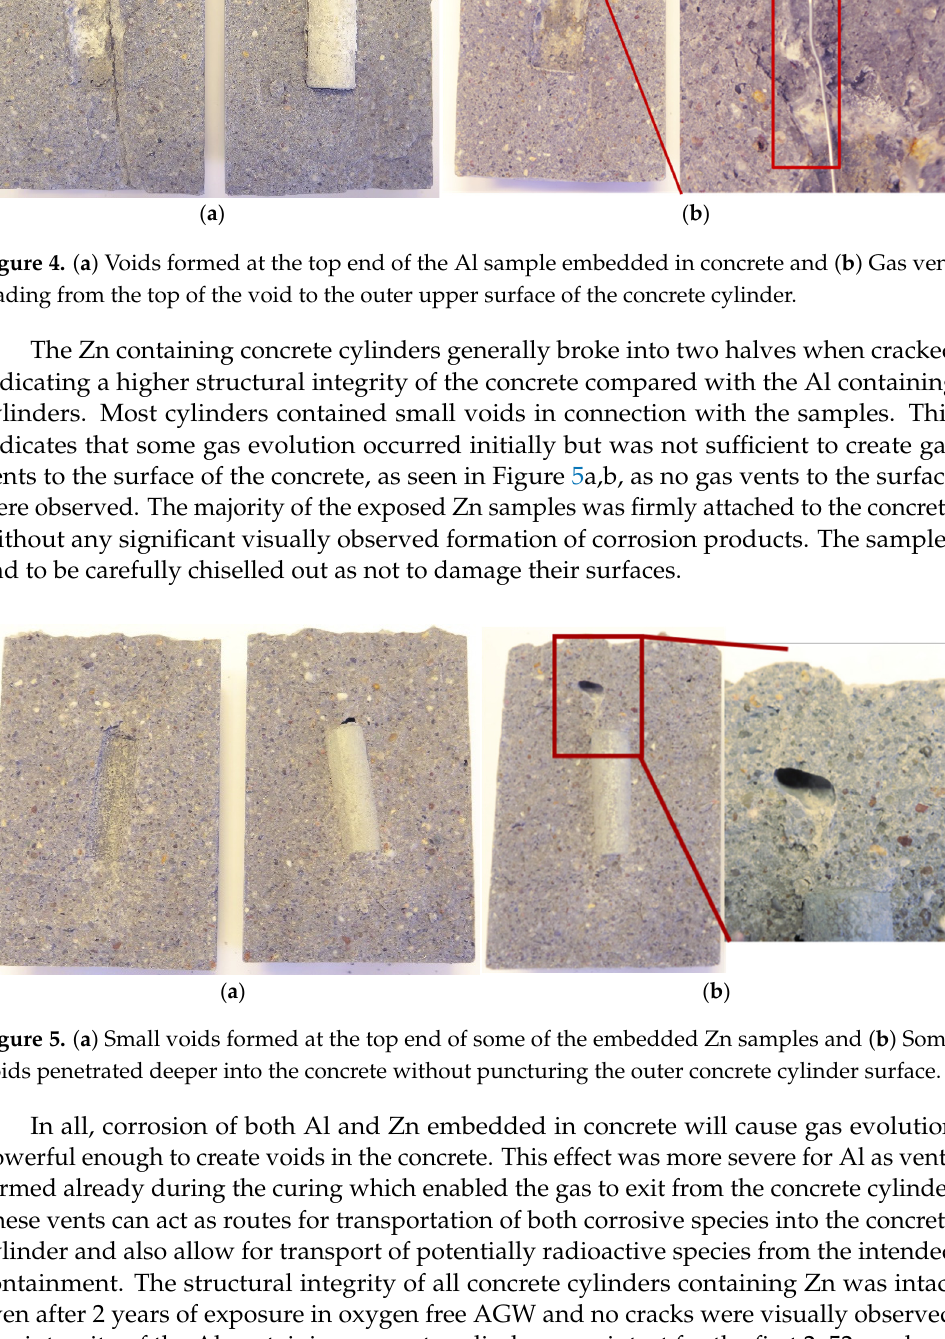
6 Figure 3. ( a ) Concrete cylinder representative for all samples and time periods except two Al con- taining cylinders (out of five) exposed for two years and ( b ) Concrete cylinder containing Al that cracked after two years of exposure. When dismounting the metal samples from the concrete cylinders after the different exposure periods, a majority of the Al-containing cylinders cracked into multiple pieces revealing voids of varying size directly above the exposed metal sample, Figure 4a. These voids had formed by the evolution of hydrogen gas as the Al samples immediately started to corrode in contact with the strongly alkaline (pH 12.5) concrete environment. The rapid initial corrosion also resulted in a large amount of corrosion products causing poor adhe- sion between the Al samples and the concrete. Consequently, the Al samples were very easy to remove after exposure from the concrete as they essentially were loose and spon-